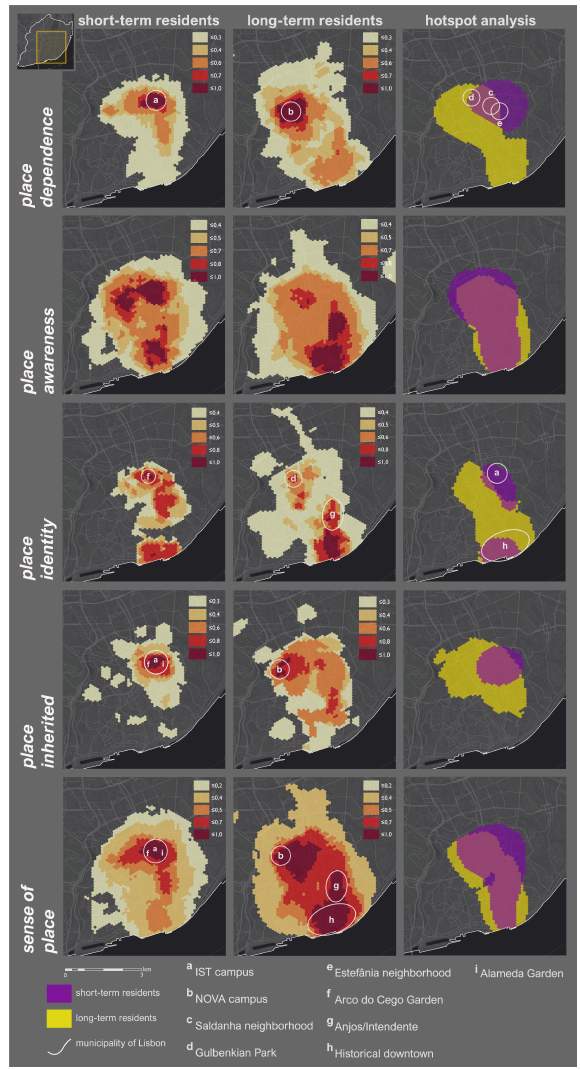
Figure 3: Distribution of overlap values higher than the upper quartile, distribution of the hotspot areas and places identified with high values of collective sense of